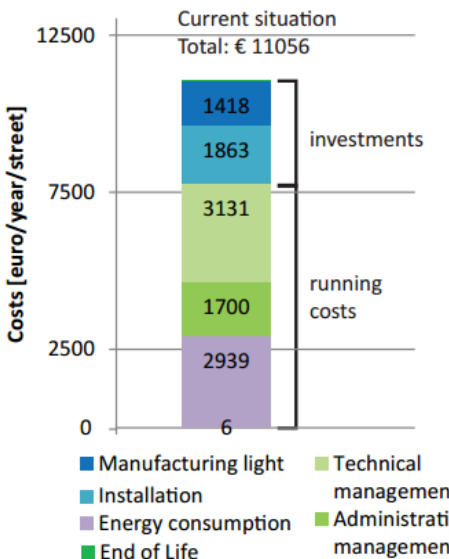
Figure 9. Costs (Total Costs of Ownership, TCO) for lighting: one street for one year of the base case.